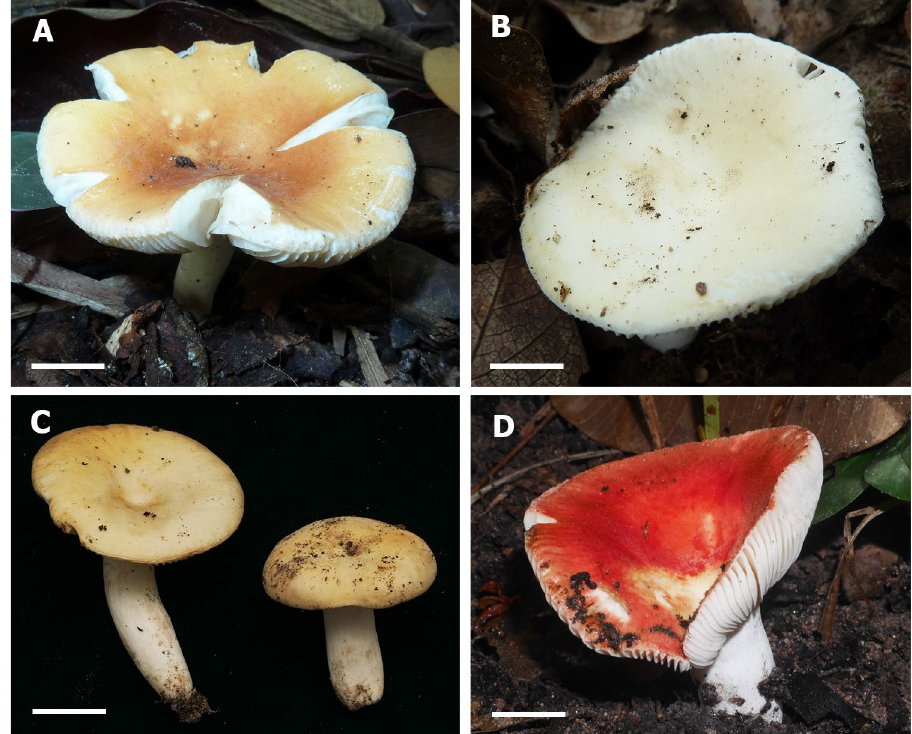
Figure 7. Basidiomata of Russula luteonana . ( A ) BBH41120 (Holotype). ( B ) BBH41121. ( C ) BBH41122. ( D ) BBH42510. Scale bar = 1 cm. Photos by Thitiya